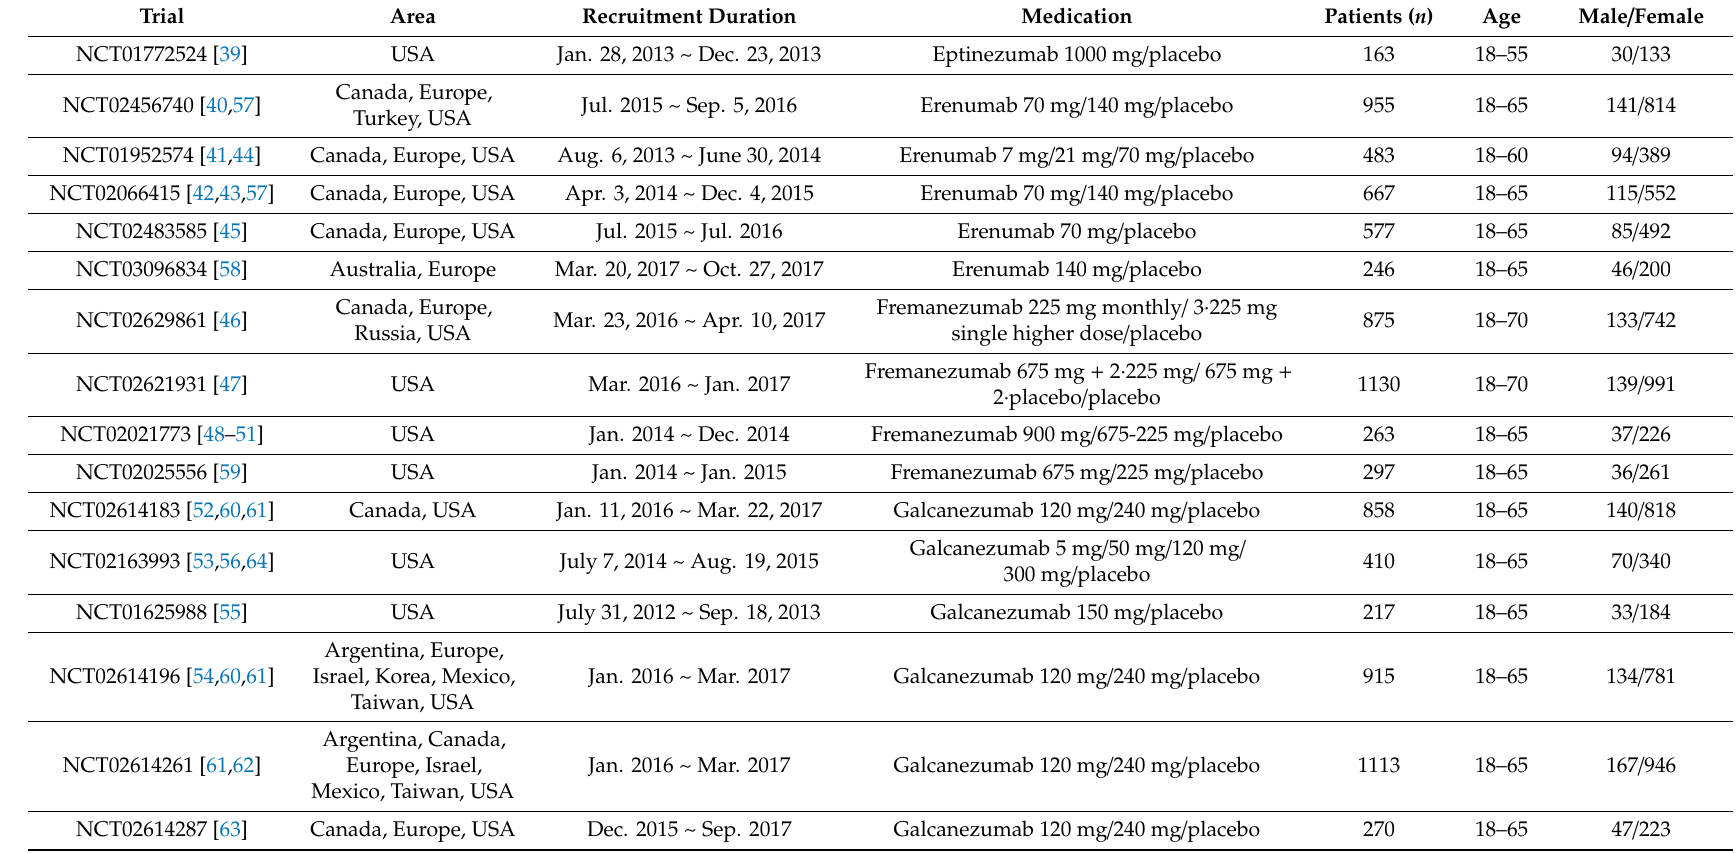
Table 1. Characteristics of the included randomized controlled